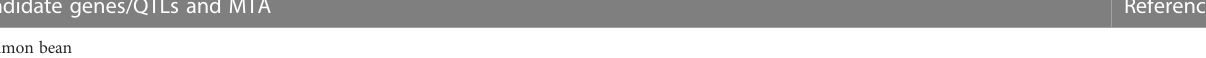
TABLE 6 Candidate genes/QTLs and marker – trait association (MTA) SNPs associated with increased seed Fe and Zn contents in food legume crops. Candidate genes/QTLs and